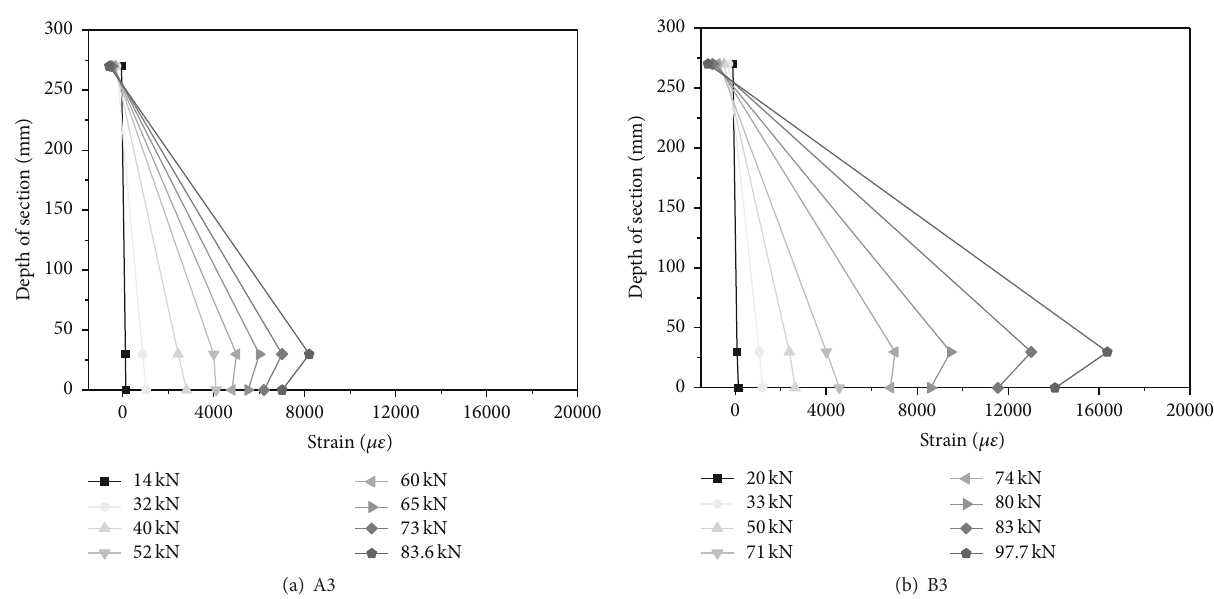
Figure 6: Comparisons of load-FRP fabric strain curves.